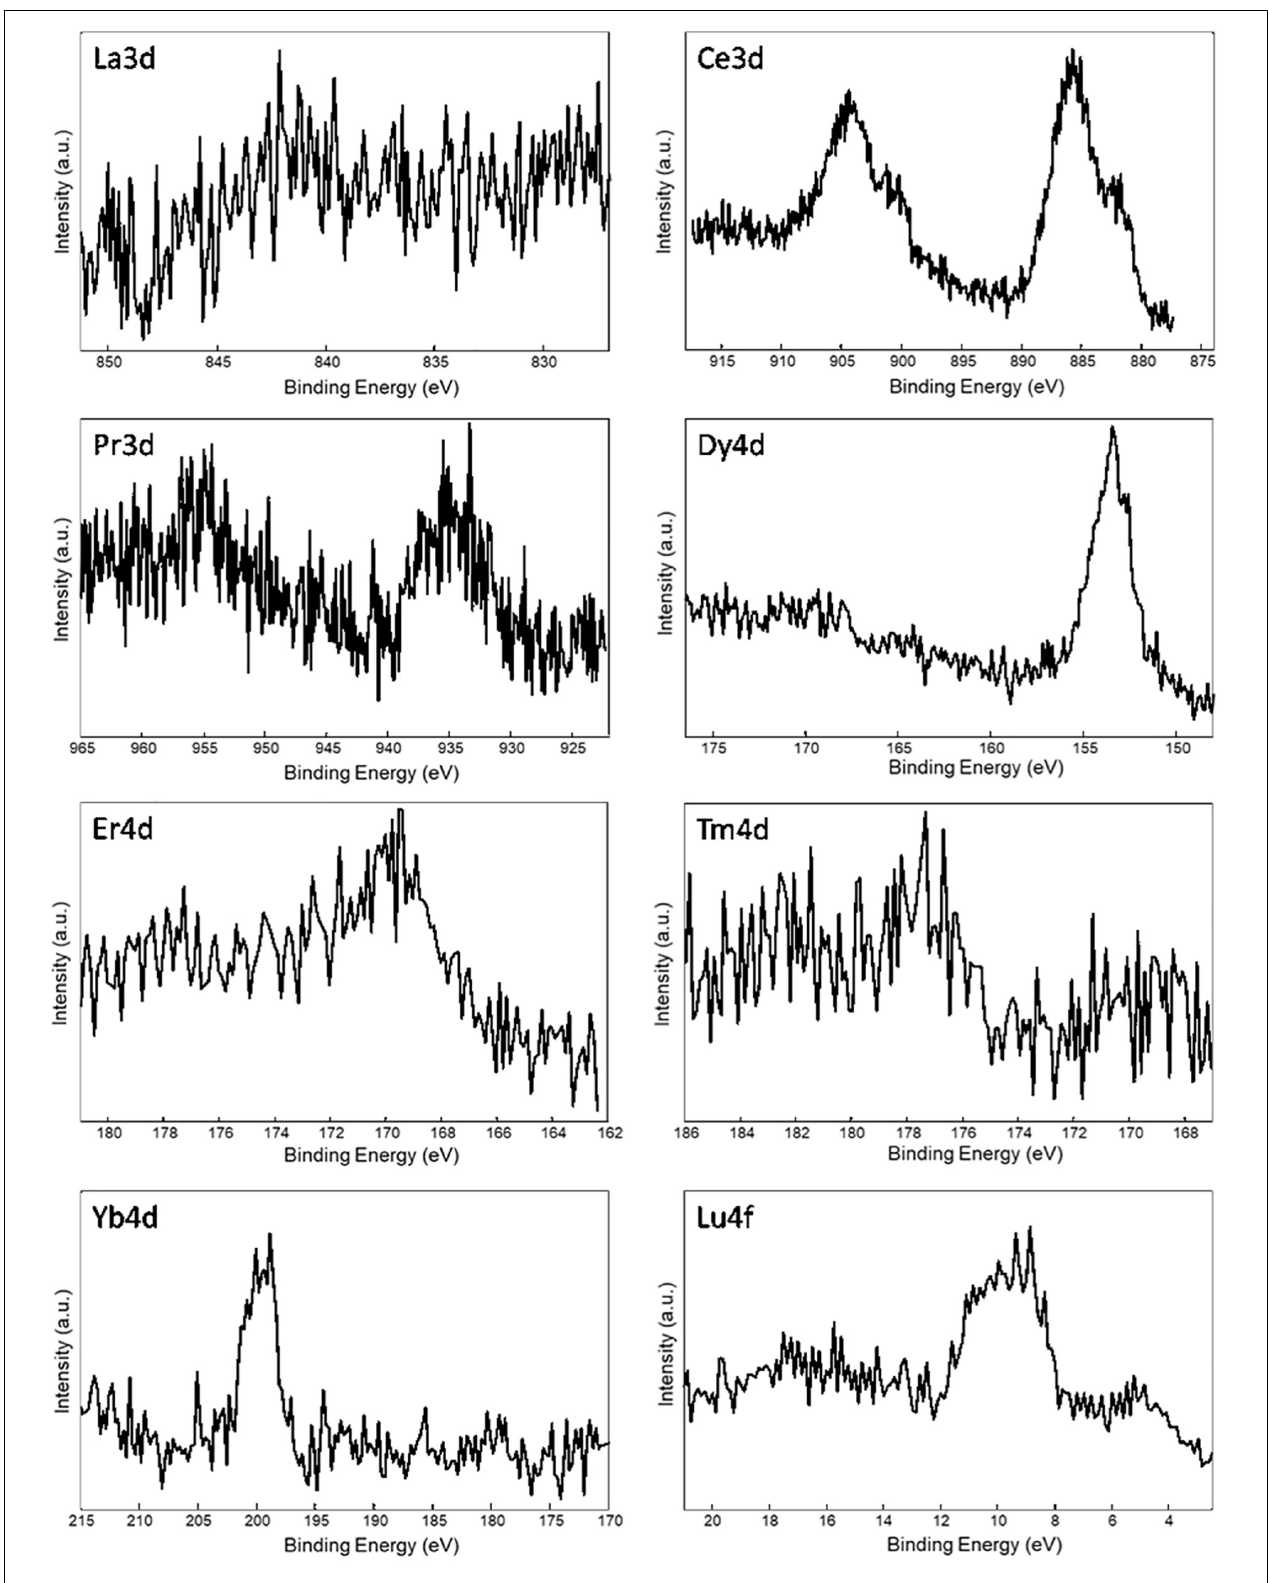
FIGURE 3 | XPS spectra of Ln + 3 /SF regenerated fibers. Selected atomic orbital for metal investigation is indicated on each spectrum.